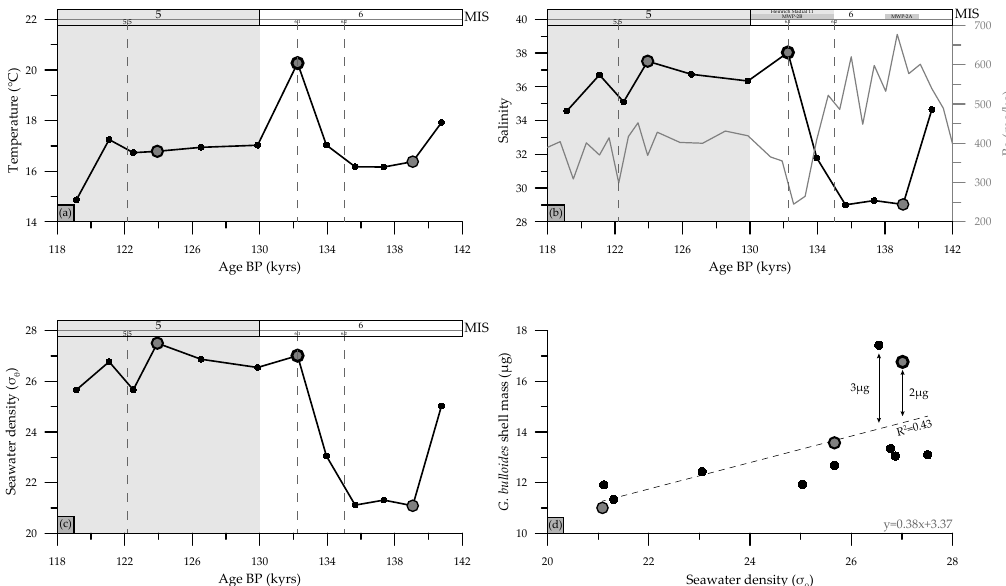
Figure 5. Geochemically reconstructed physical oceanographic parameters for the period surrounding T-II and their relation to average G. bulloides shell weights: ( a ) temperature estimates based on Mg / Ca ratios; ( b ) salinity reconstructions based on coupled Mg / Ca and δ 18 O measurements together with Barium (Ba) X-ray fluorescence (XRF) counts; ( c ) ambient seawater density reconstructions based on the preceding temperature and salinity estimates; ( d ) shell mass and seawater density regression plot. The two upper right points are the increased shell mass samples that deviate from the regression line by 2 and 3 µ g, respectively. At the lower right, the contamination corrected regression equation is shown. Enlarged circles denote the samples that have been X-ray microscopically analysed. The thickness of their envelope line is proportional to the average shell wall thickness shown in Table 1. Data are available in the Supplementary Tables and XRF data from